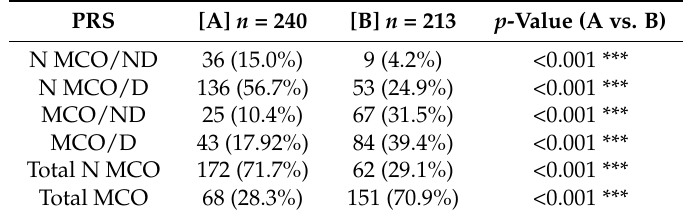
Table 1. Maturity and reproductive status statistical results (Experiment